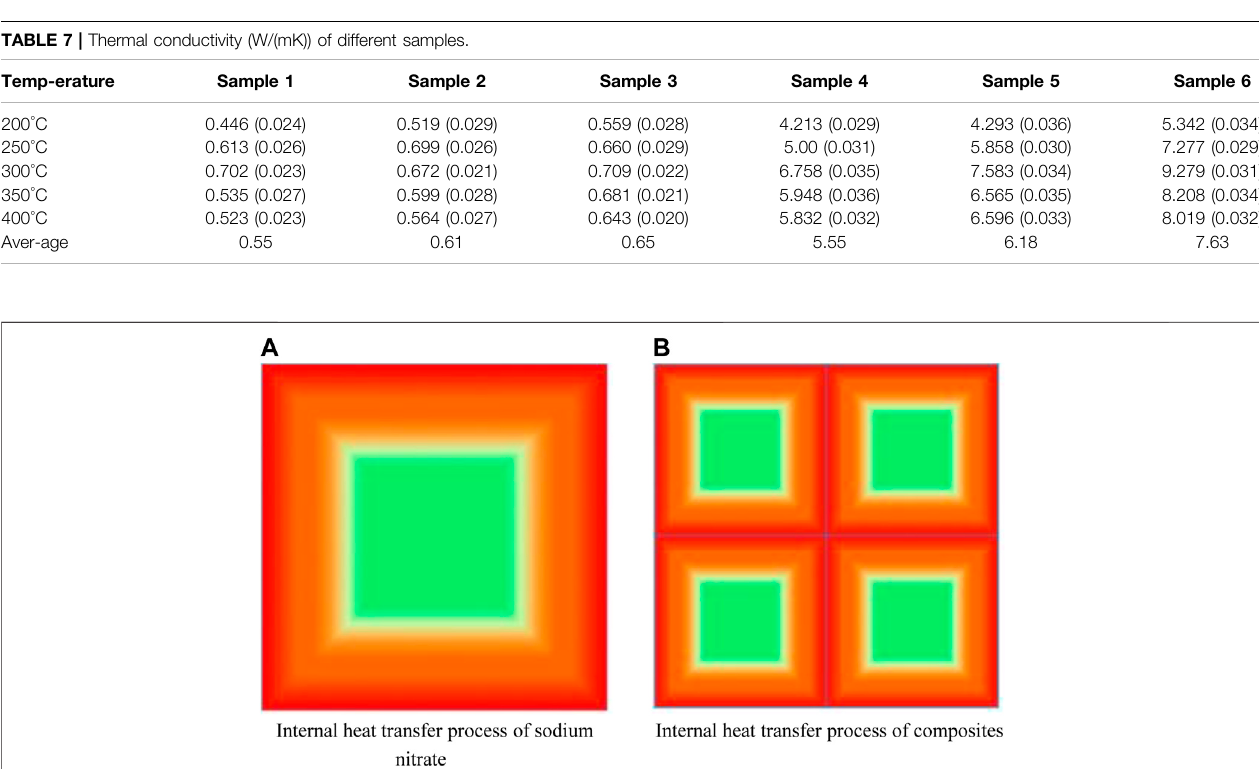
Frontiers in Energy Research |